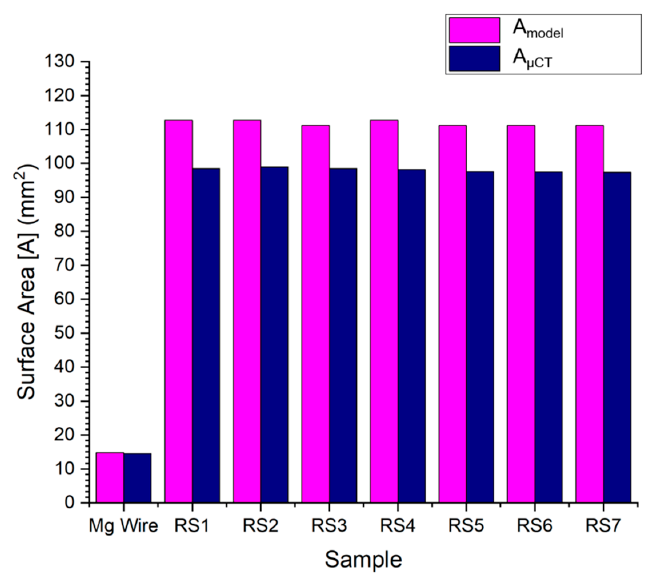
Figure 7. Results of the entire stent surface area, calculated by the developed model and micro-CT.